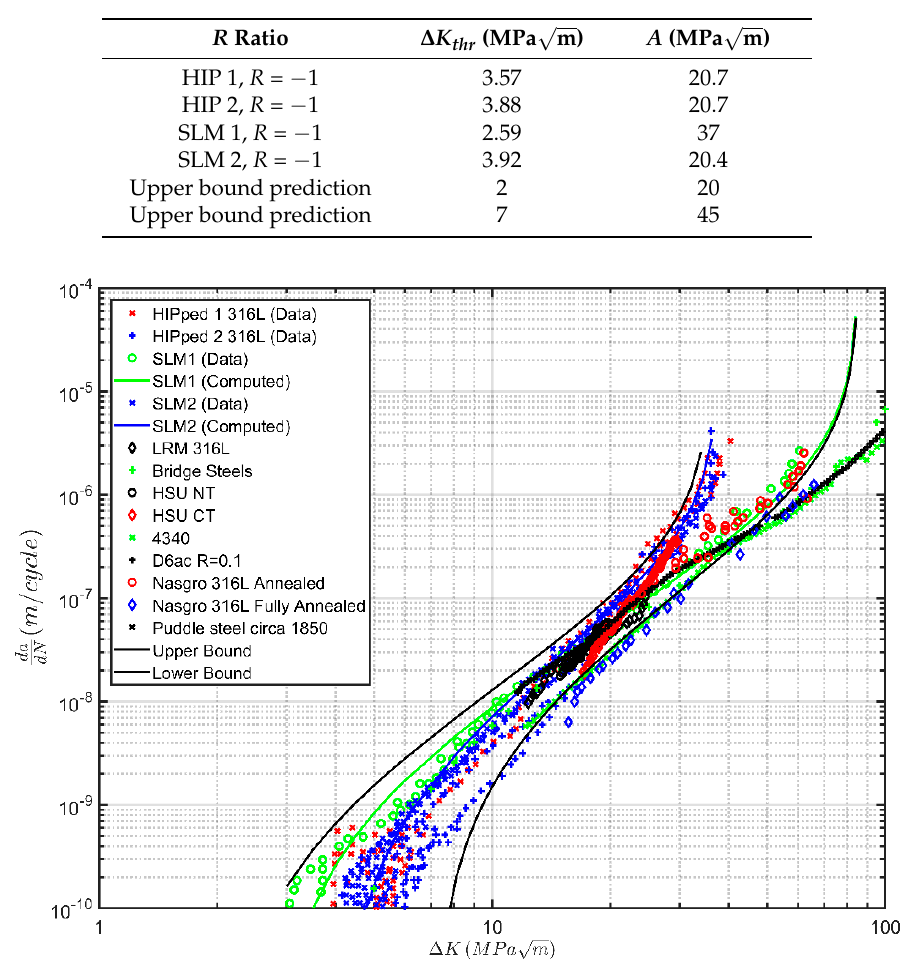
Table 6. Values of ∆ K thr and A used in Figure 8.